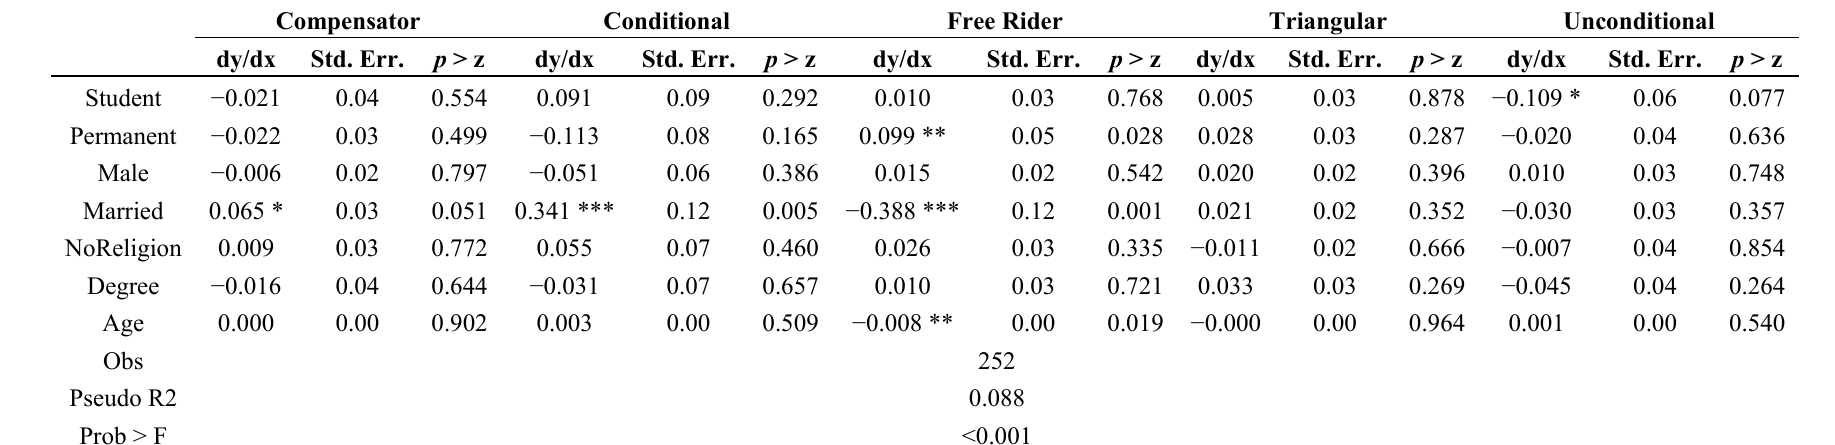
Table 4. Multinomial logit (Strategy